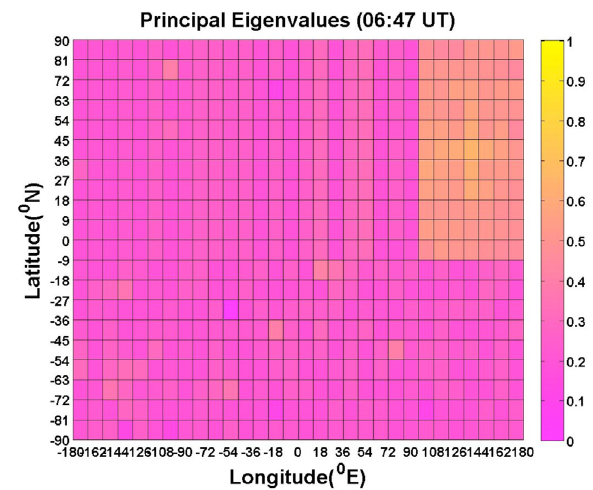
Figure 7. The figure gives a color-coded scale of the magnitudes of principal eigenvalues corresponding to Figure 4.